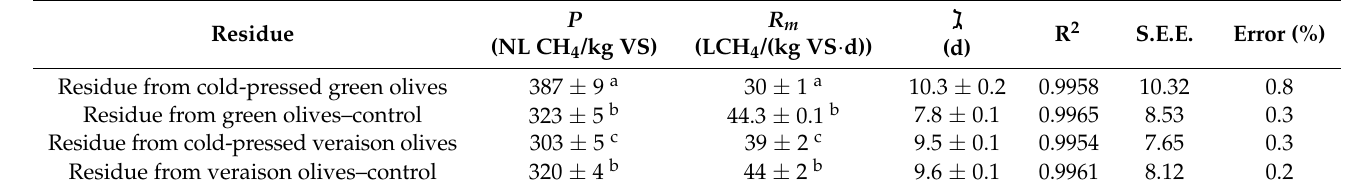
Table 4. Values corresponding to the parameters obtained from the logistic model (Sigmoidal 4 parameters) for the four mixture residues studied. Values represent means ± standard deviations. Different superscripted letters (a–c) mean values are significantly